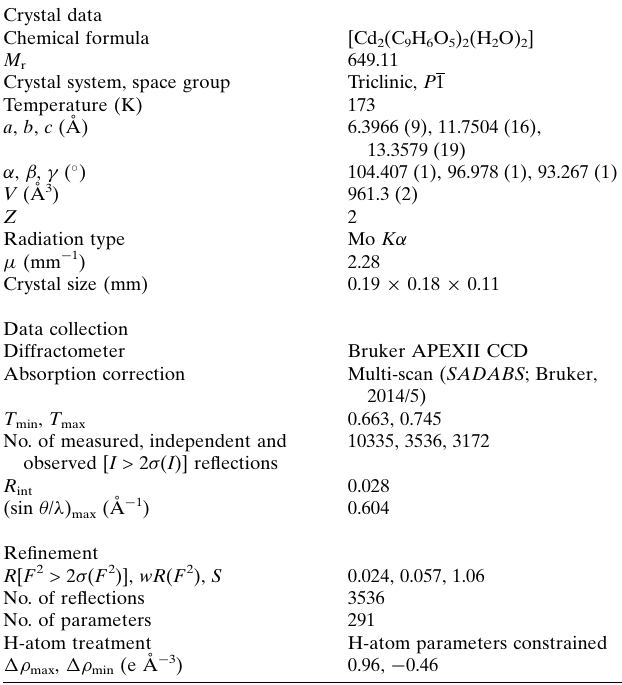
Crystal data Chemical formula